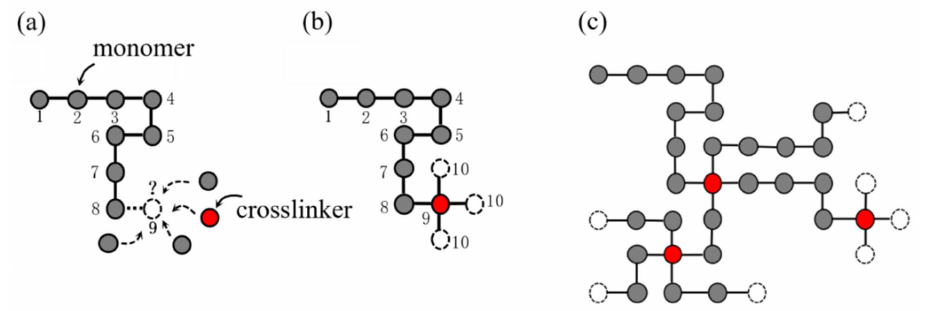
Figure 3. Schematics of SAW network generation model in 2D space. ( a ) The probability of what kind of particles to be inserted depends on the number of remaining monomers and crosslinkers. ( b ) Generation of new chain ends when inserting a crosslinker. ( c ) More chains walk in space to form a